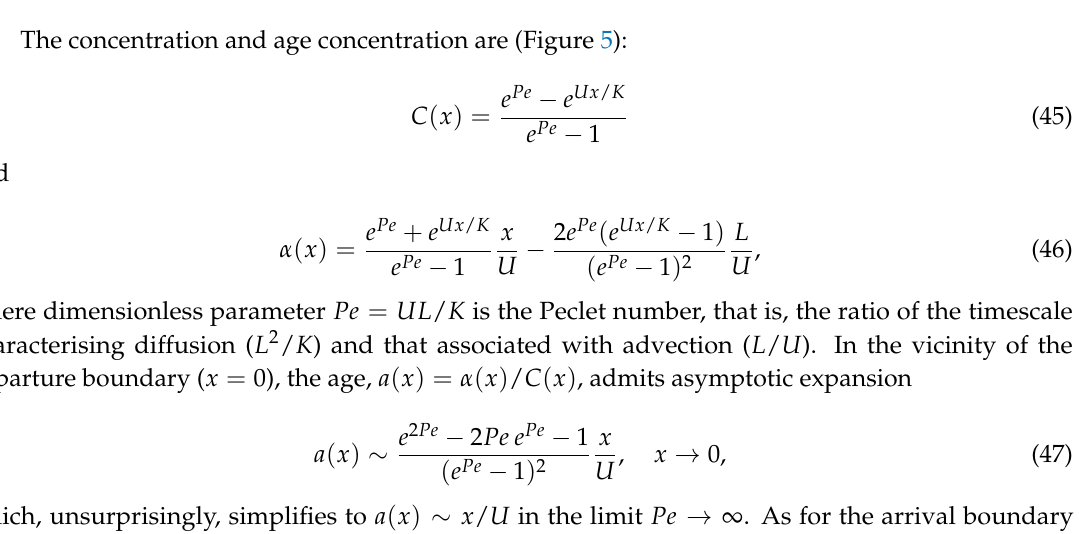
Figure 4. Schematic representation of a finite-sized domain ( x ∈ [ 0, L ] ) with a departure boundary at x = 0 and an arrival one at x = L . Dirichlet boundary conditions are prescribed on the boundaries. An alternative treatment of the arrival boundary leads to the implementation of Neumann boundary conditions at x = L